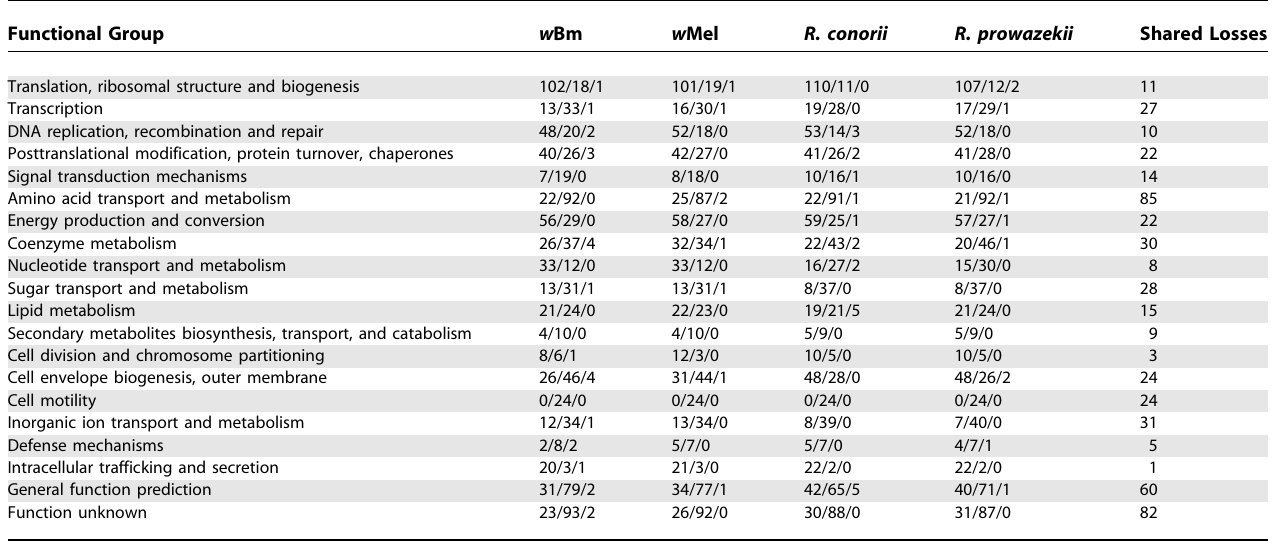
Table 2. Gene Loss and Decay in Wolbachia and Rickettsia Functional